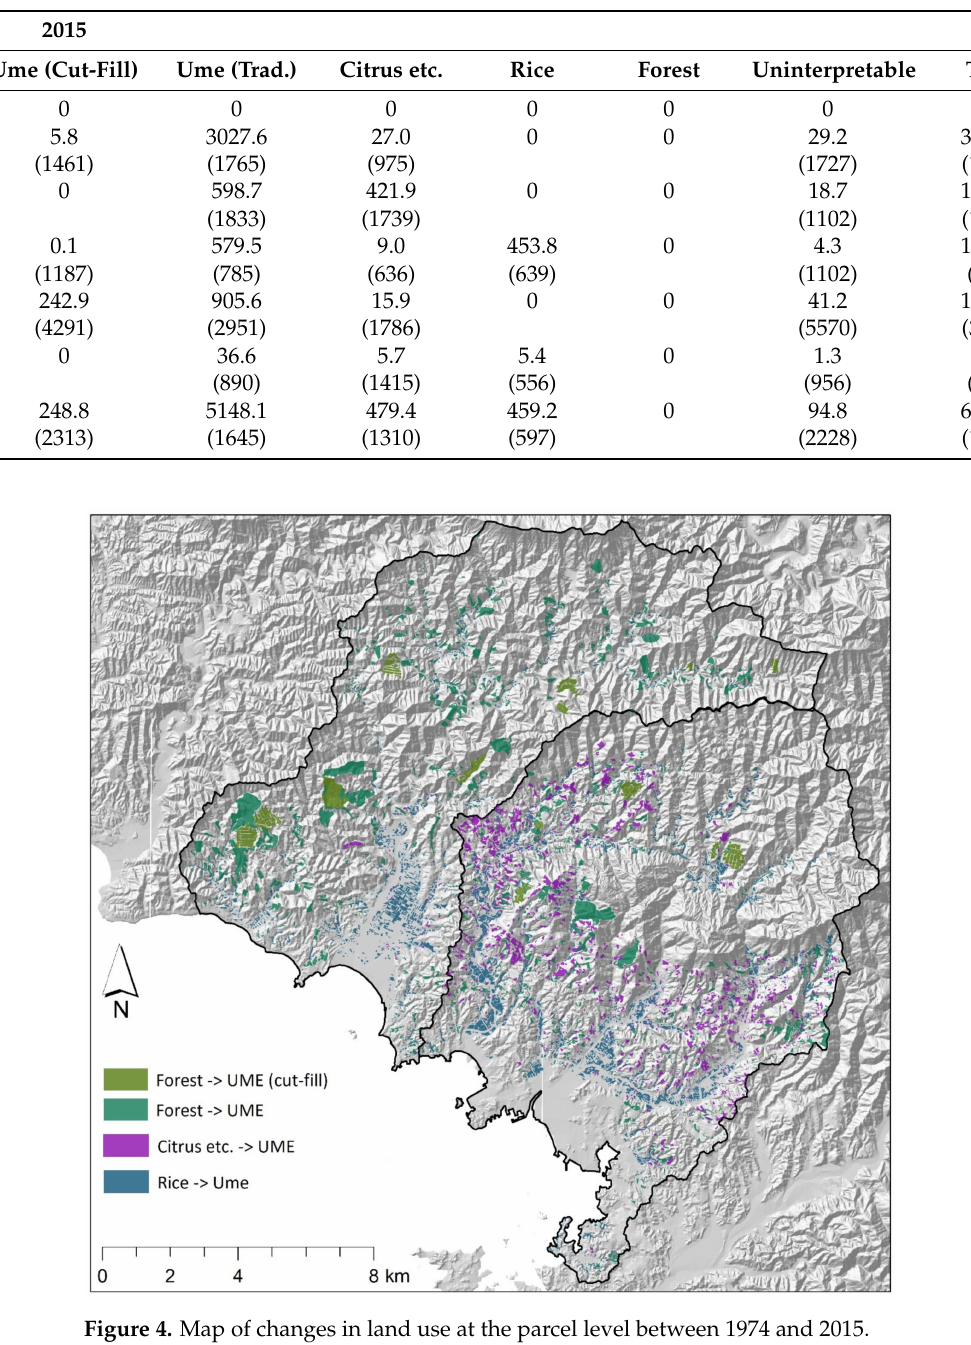
Table 1. Cross table of areas (in hectares) altered between 1974 and 2015. Numbers in parentheses are average parcel sizes in m 2 .